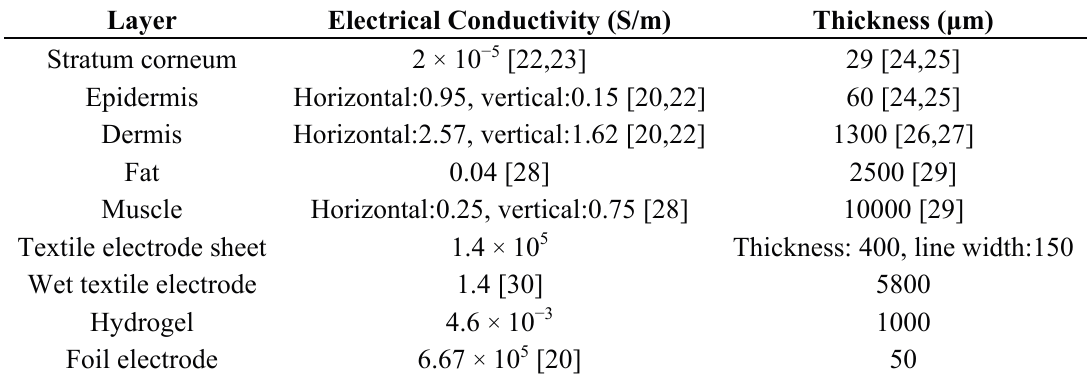
Figure 4. Finite element model of dry textile electrode; three dimensional view of the model is shown in ( a ), side view is shown in ( b ), and the details of modeled dry textile electrode is shown in ( c ). Table 1. The electrical conductivity and thickness of each layer in the finite element